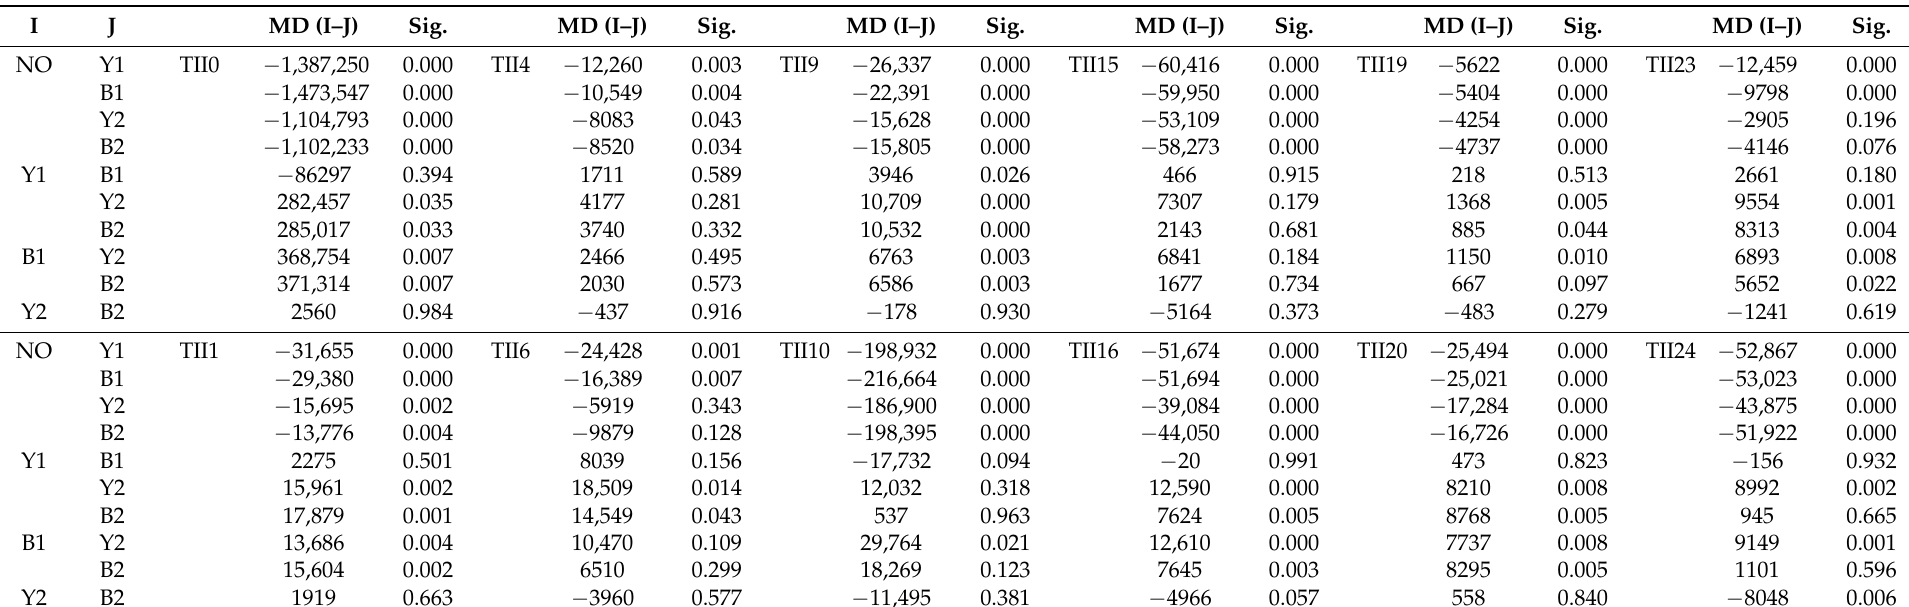
Table A2. Tertiary industry income—post hoc tests—multiple comparisons using